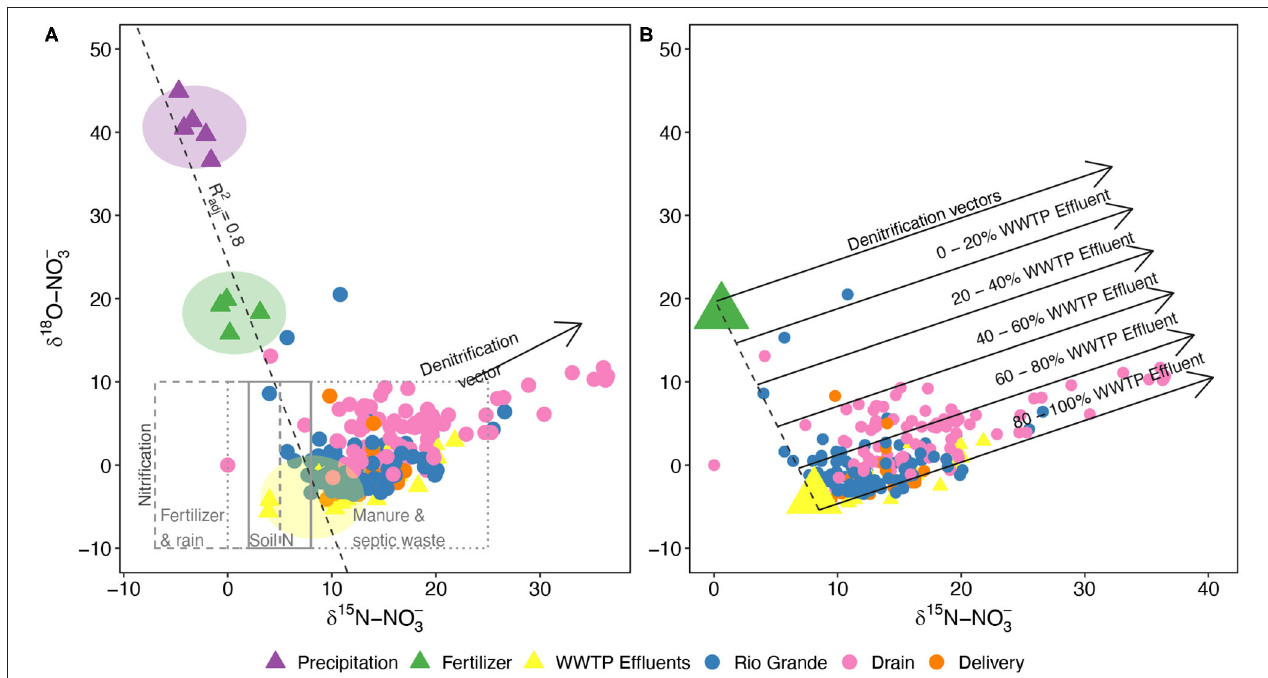
FIGURE 6 | (A) Isotope biplot of δ 15 N and δ 18 O of dissolved NO 3 within the Middle Rio Grande watershed. Triangles indicate the three main sources of measured NO 3 : precipitation, liquid fertilizer ( Sanchez et al., 2017), and WWTP effluents (this study). Typical ranges of isotope values of nitrate derived from the nitrification of ammonium in fertilizer and rain, soil, and organic waste are shown in the gray boxes [values based off Kendall (1998)]. Colored circles indicate the three main reaches studied. Shifts toward microbial denitrification are signified by the vector. The dotted line represents a linear regression ( R 2 adj = 0.82) performed among the highlighted (in circles) main sources of nitrate, excluding WWTP effluents that trend toward denitrification. None of the samples plot near precipitation, indicating the end-member’s negligible contribution to dissolved nitrate. (B) Estimation of the relative contributions of nitrate sources using δ 15 N and δ 18 O. Precipitation had minimal influence on the isotopic signature of samples, and therefore a two-endmember mixing model was used to estimate the NO 3 contributions of liquid fertilizer and WWTP effluent. Large triangles indicate the averages of the two endmember sources and colored circles denote the watershed samples of the three main reaches of the Rio Grande. The effects of denitrification can be parsed by analyzing the samples with respect to the parallel vectors, e.g., samples that fall between the upper two vectors were derived from 0 to 20% WWTP effluent (and therefore 80–100% fertilizer), regardless of the timing of the denitrification reactions.